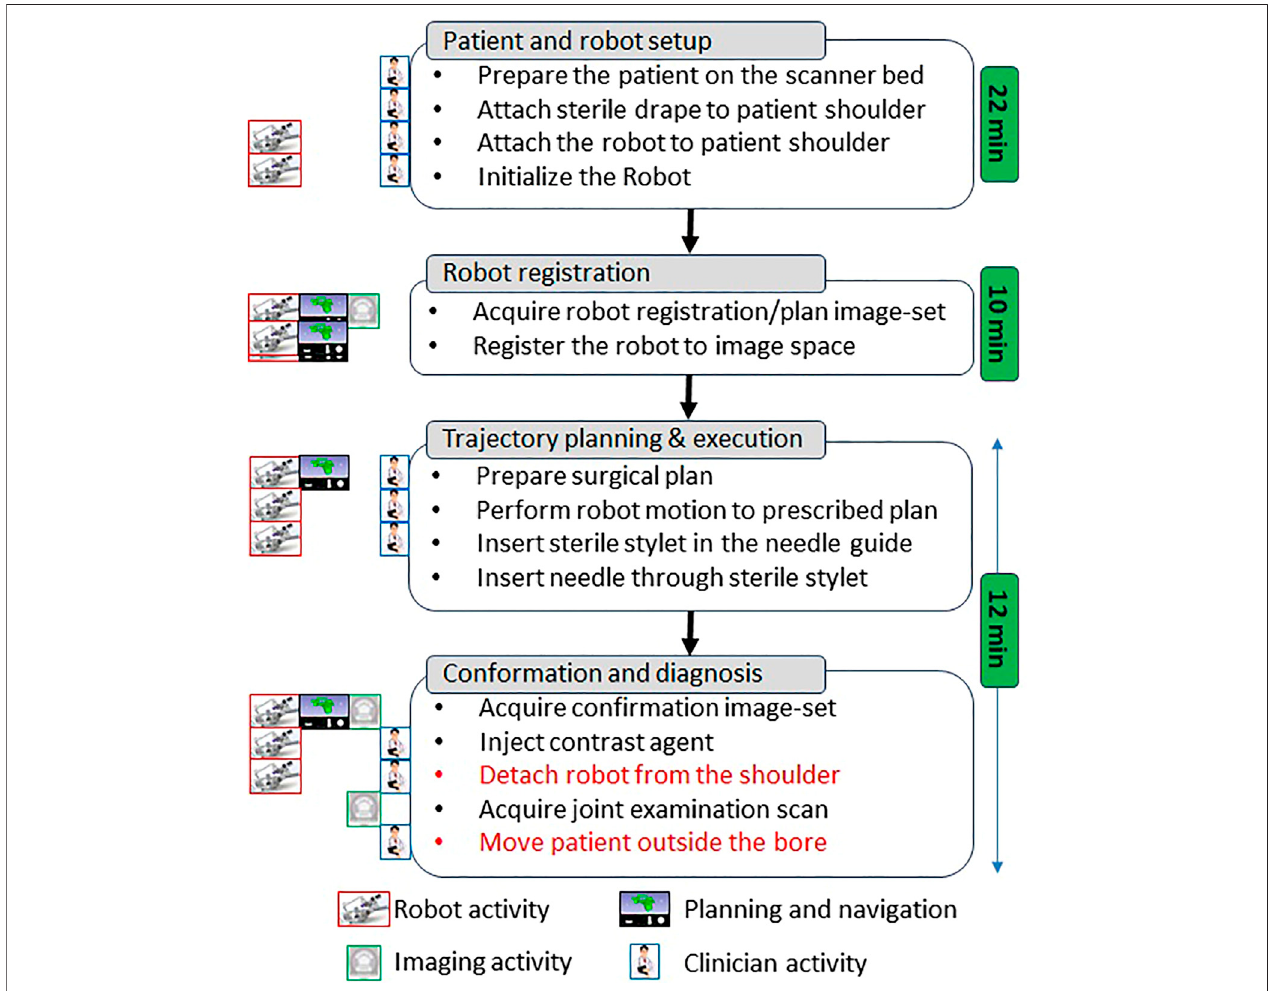
FIGURE4| Proposed clinicalwork fl ow showing various stepsfor therobot-assisted, MRI-guided shoulderarthrography procedure. Procedureisdivided intofour phases, at the left of each activity shows what/who are involved for that activity, while for each phase measured average time is noted on the right. Duration for activities shown in red is not considered for the presented cadaver study as multiple targeting attempts were made in the same session.